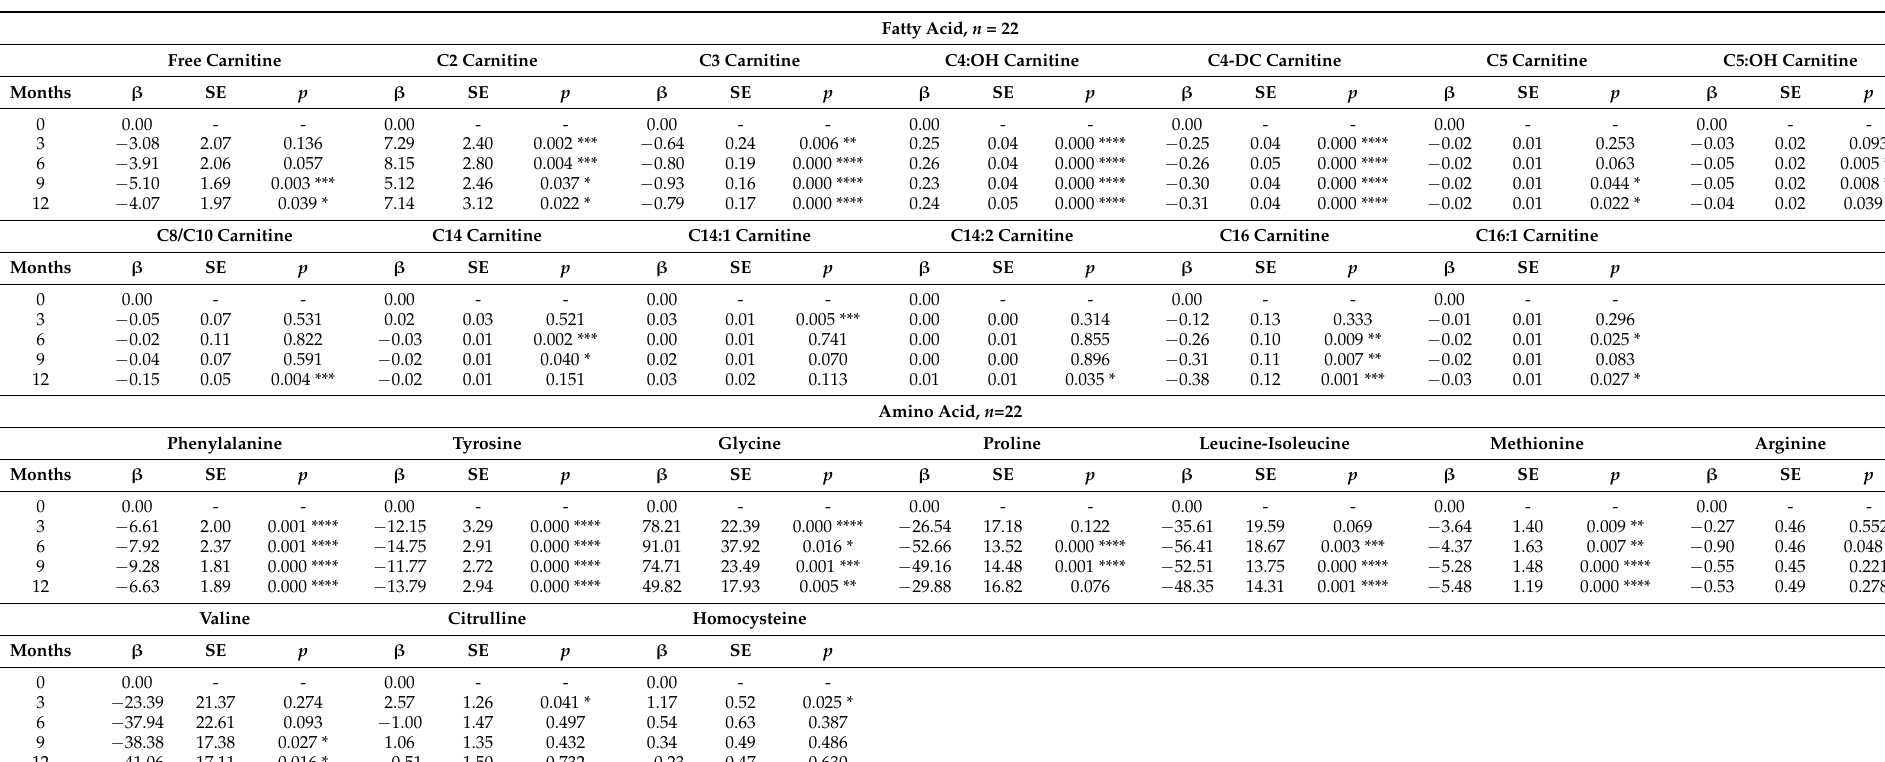
Table 1. Fatty acid acylcarnitines and amino acids at different time point of KDT for 22 study subjects.Fatty acid acylcarnitines and amino acids were checked at baseline and after 3, 6, 9, and 12 month of ketogenic diet therapy. All statistically significant values are